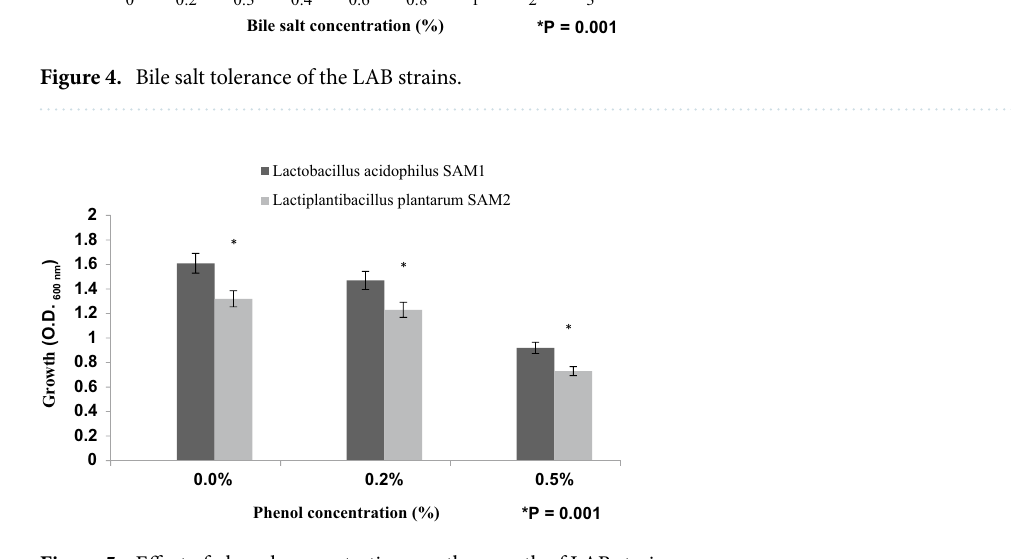
Figure 5. Effect of phenol concentrations on the growth of LAB strains.